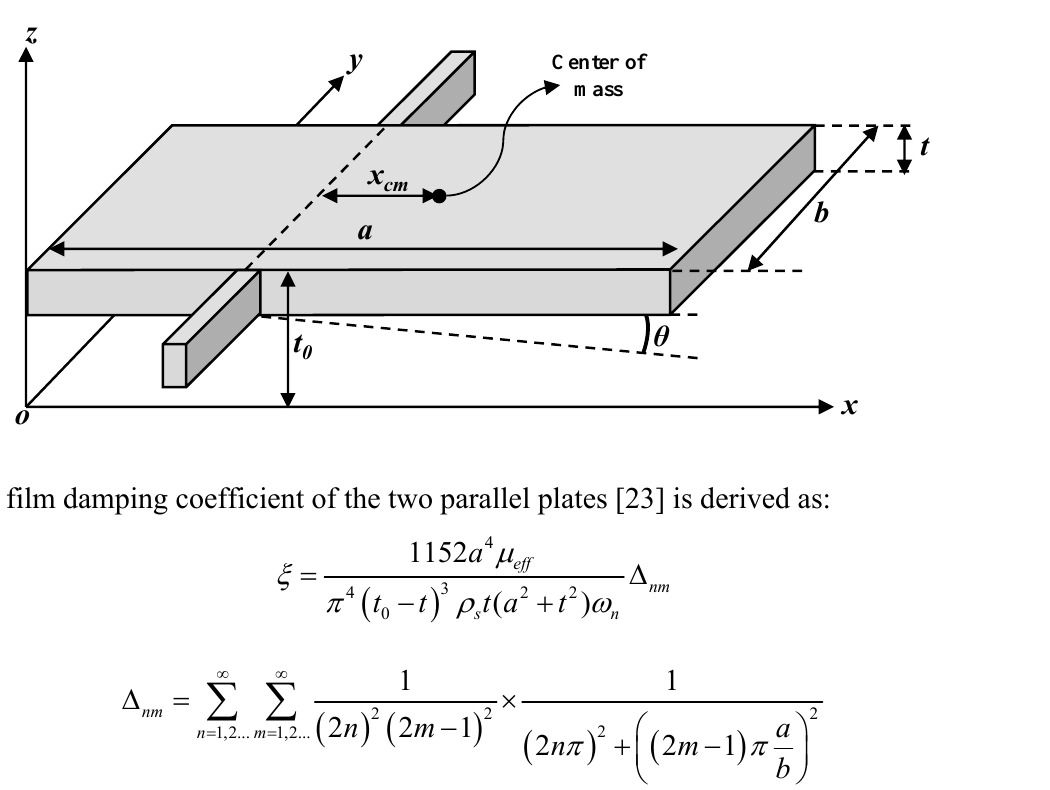
Figure 3. A Simplified schematic of the torsional microaccelerometer.